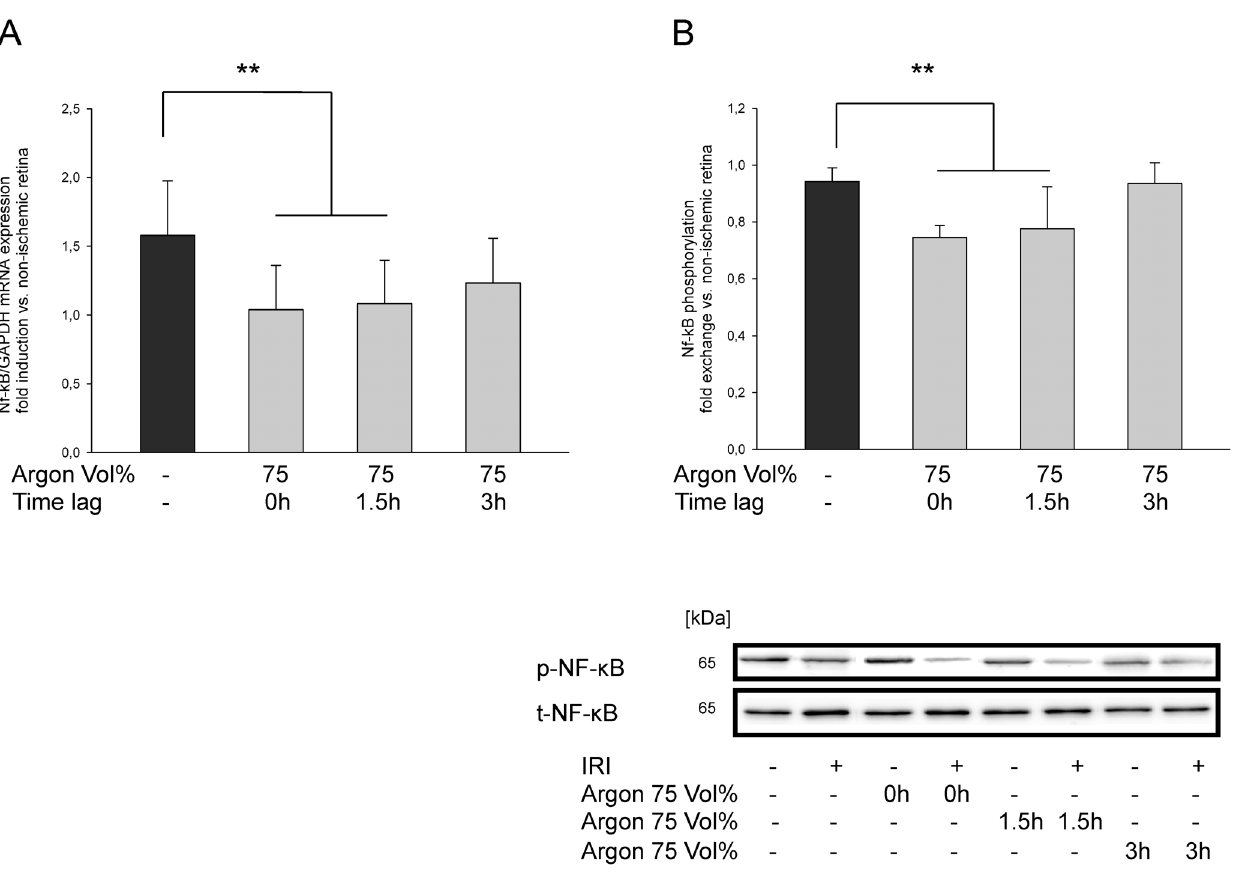
Fig. 8. Effect of Argon inhalation on retinal expression of NF- k B mRNA and NF- k B phosphorylation. ( A ) Fold induction of NF- k B mRNA expression after time-dependent inhalation of Argon 75 Vol% in ischemic retinal tissue compared to GAPDH in relation to the corresponding non-ischemic retinae analyzed by RT-PCR (n 5 8; data are mean ¡ SD; ** 5 p , 0.01 IRI vs. IRI + Argon at all time points). ( B ) Densitometric analysis of n 5 8 western blots for NF- k B phosphorylation after time-dependent inhalation of Argon 75 Vol% (data are mean ¡ SD; *** 5 p , 0.01 IRI vs. IRI + Argon immediately and at 1.5 h delayed treatment) and representative western blot image (n 5 8) showing the suppression of retinal NF- k B phosphorylation compared to total NF- k B expression.